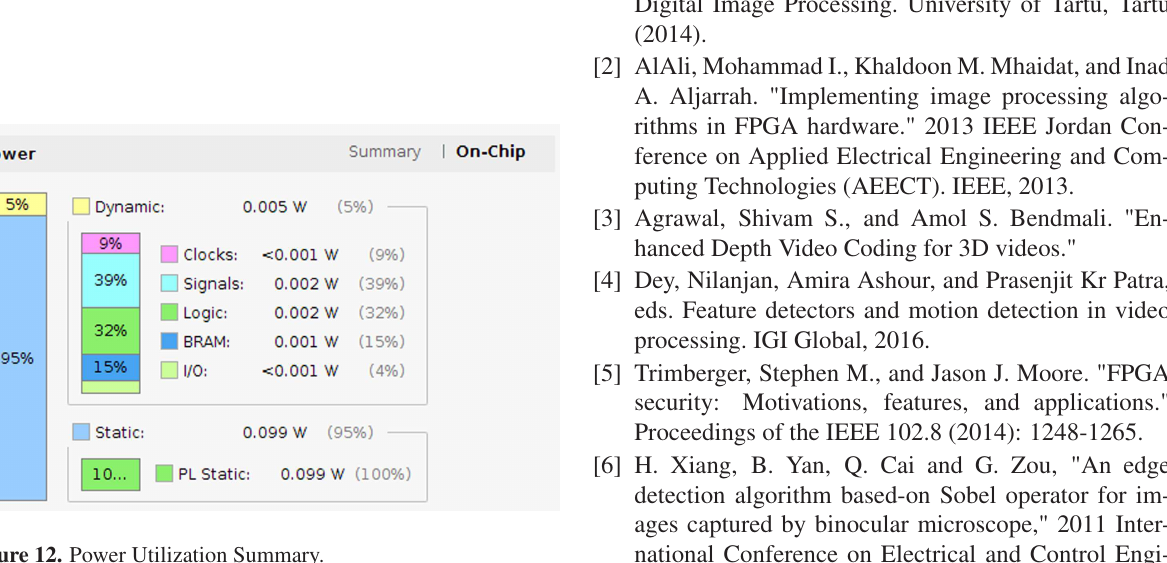
Figure 6. MATLAB result of Sobel Operator. Figure 9. Interfacing of Nexys 4 DDR board with VGA.